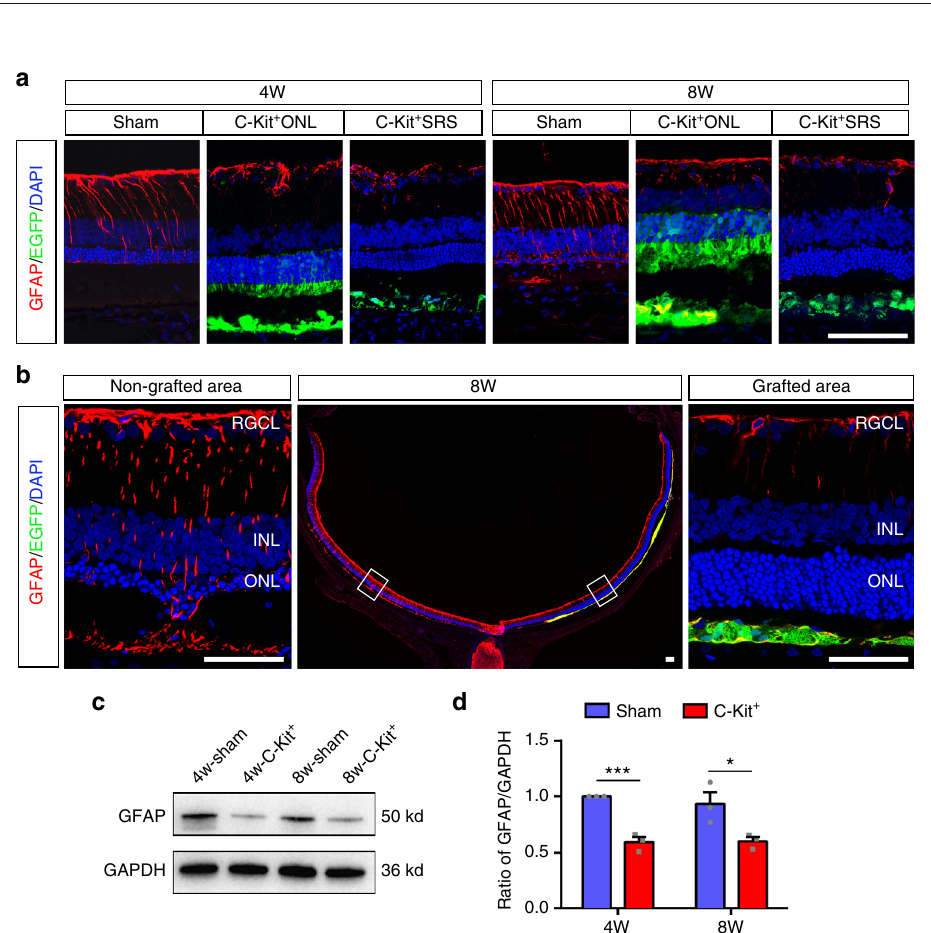
Fig. 7 Suppression of gliosis through C-Kit + cells transplantation in RCS rats. a GFAP staining in the C-Kit + cell group (both C-Kit + ONL and C-Kit + SRS) and the sham group at PO 4w and 8w. b Whole retinal section image showing GFAP staining in the non-grafted area and the grafted area at PO 8w. c , d Western blot analysis of GFAP protein level ( n = 3 eyes/group). P values were determined by unpaired two-tailed Student ’ s t -test: * P < 0.05; ** P < 0.01; *** P < 0.001. Data are presented as mean ± SEM. Scale bars, 100 μ m ( a , b ) material transfer was suggested to be a speci fi c property of PPCs, whereas RPCs from mouse embryos were thought to rarely transfer material to host photoreceptors 27 . Nonetheless, we demonstrated that C-Kit + cells, which are also RPCs, do transfer EGFP to host photoreceptors and even potentially to various types of retinal cells, including RPE cells, ganglion cells, bipolar cells, and Müller glial cells. This fi nding indicates that material transfer is more common than has been previously thought. However, the factors that determine the relative ratio of inte- gration and material transfer and the relative contributions of the two processes to photoreceptor rescue remain to be elucidated.